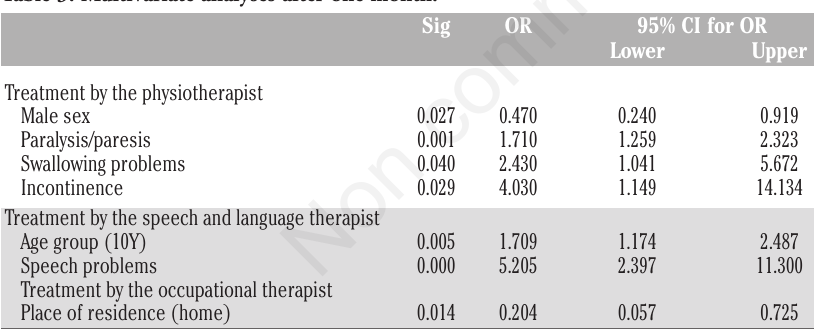
Table 3. Multivariate analyses after one